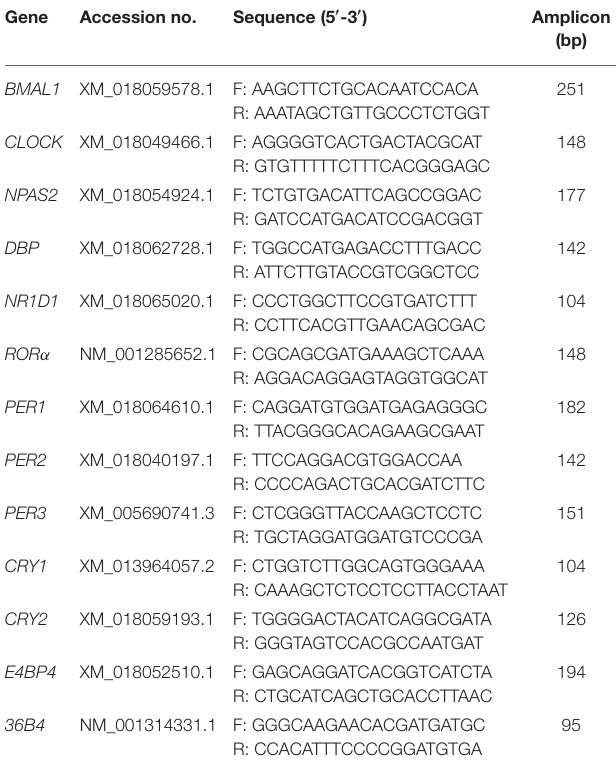
TABLE 1 | Primer sequences for the goat targeted genes in